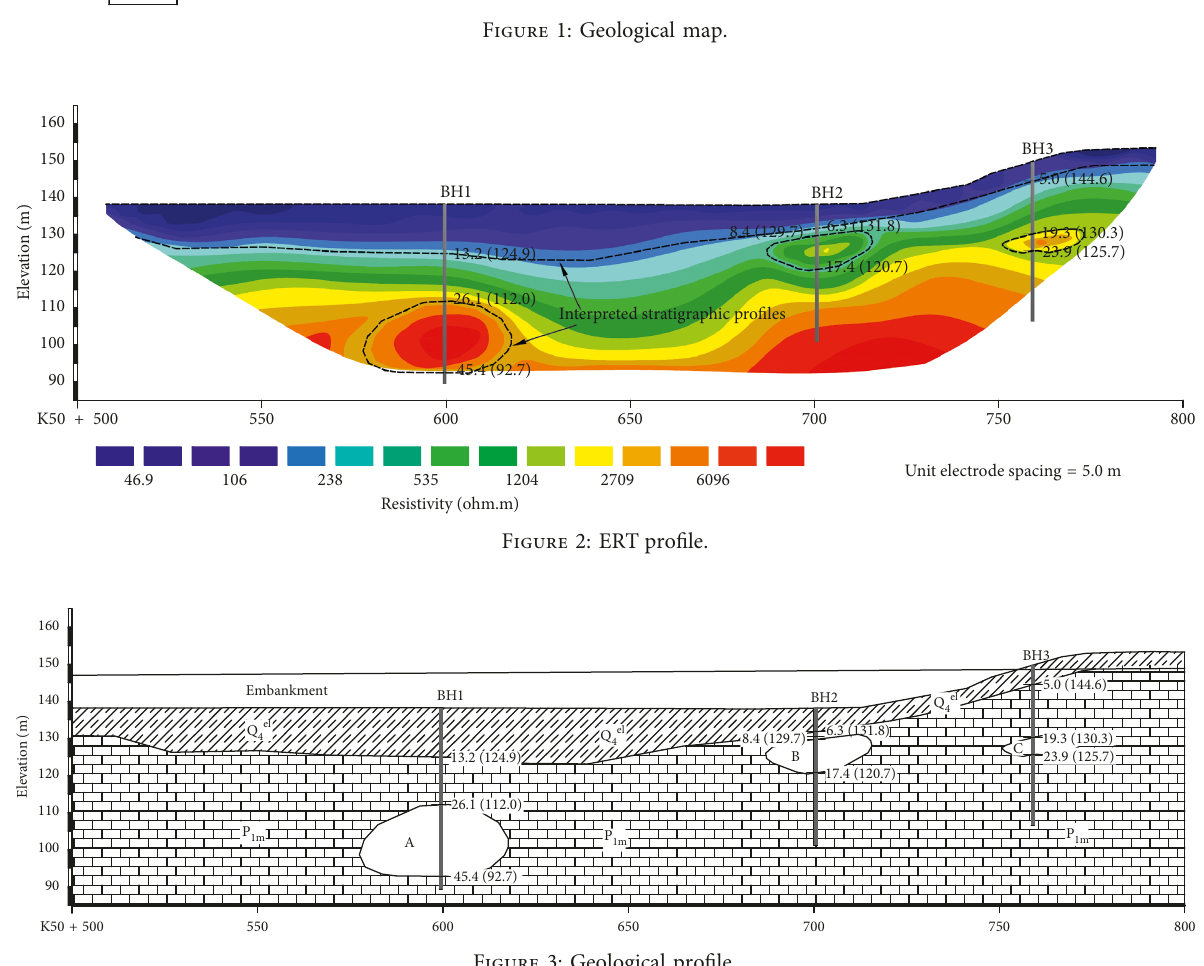
Figure 1: Geological map.